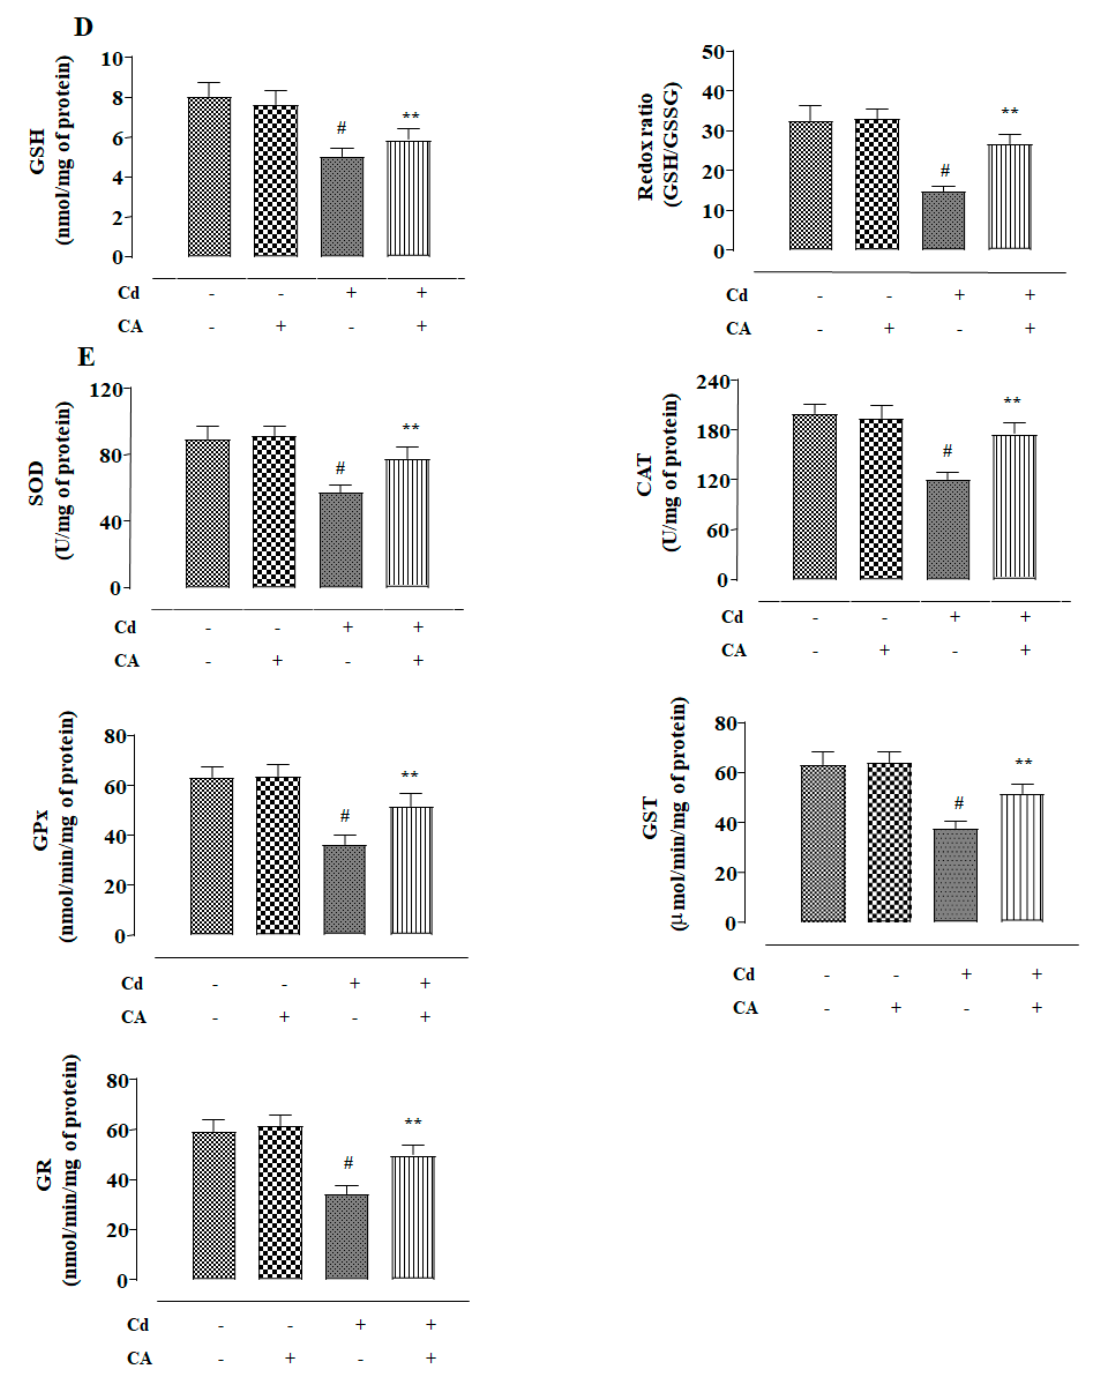
Figure 2. The e ff ects of CdCl 2 and / or CA on the redox imbalance in vitro on NKE cells. ( A ) The e ff ect on reactive oxygen species (ROS) accumulation. ( B ) The e ff ects on NO production, H 2 O 2 level, and reduced Nicotinamide Adenine Dinucleotide Phosphate (NADPH) oxidase activity. ( C ) The e ff ects on lipid peroxidation and protein carbonylation. ( D ) The e ff ects on reduced glutathione (GSH) level and redox ratio. ( E ) The e ff ects on endogenous antioxidant molecules. Data were represented as the mean ± SD, n (number of plates) = 3. # Values significantly ( p < 0.01) di ff ered from the vehicle-treated group. * Values significantly ( p < 0.05) di ff ered from only the CdCl 2 -treated group. ** Values significantly ( p < 0.01) di ff ered from only the CdCl 2 -treated group. Superoxide dismutase (SOD) unit, “U”, is defined as inhibition ( µ -moles) of nitro blue tetrazolium (NBT)-reduction / min. Catalase (CAT) unit, “U”, is defined as H 2 O 2 consumption / min.